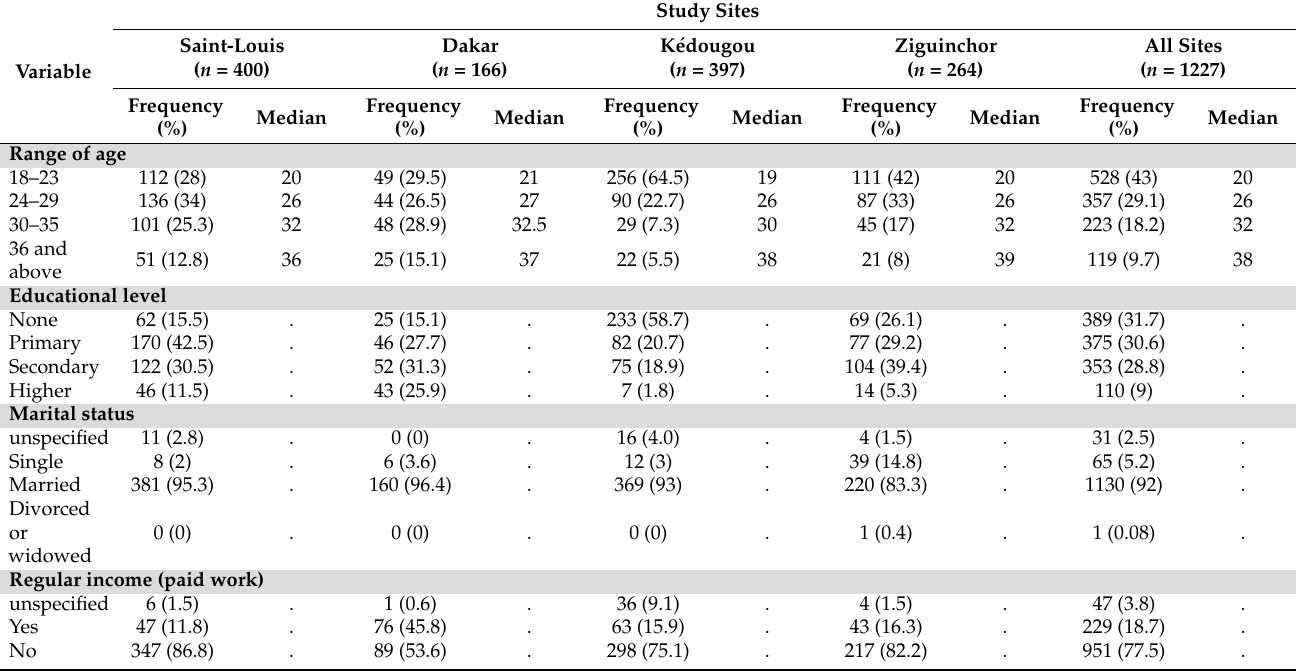
Table 1. Socio-demographic characteristics of pregnant women and HEV